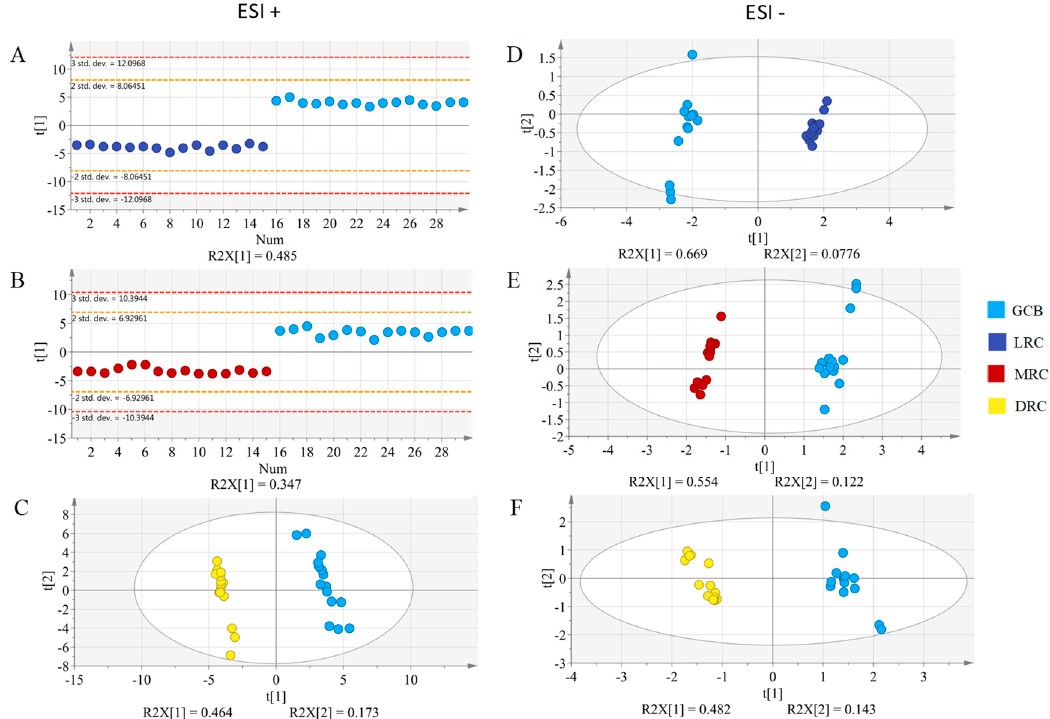
Figure 2. Partial least squares discrimination analysis (PLS-DA) score plots for LRC, MRC, and DRC compared with GCB in positive ( A , B , and C , respectively) and in negative ( D , E , and F , respectively) ionization modes.